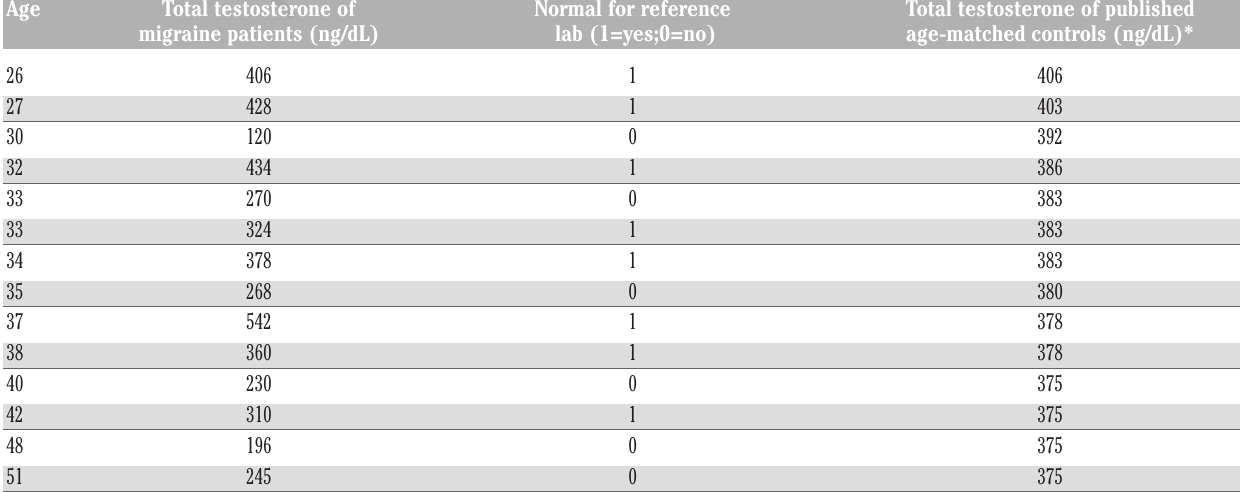
Table 1. Total testosterone levels of migraine patients compared to published age-matched controls.